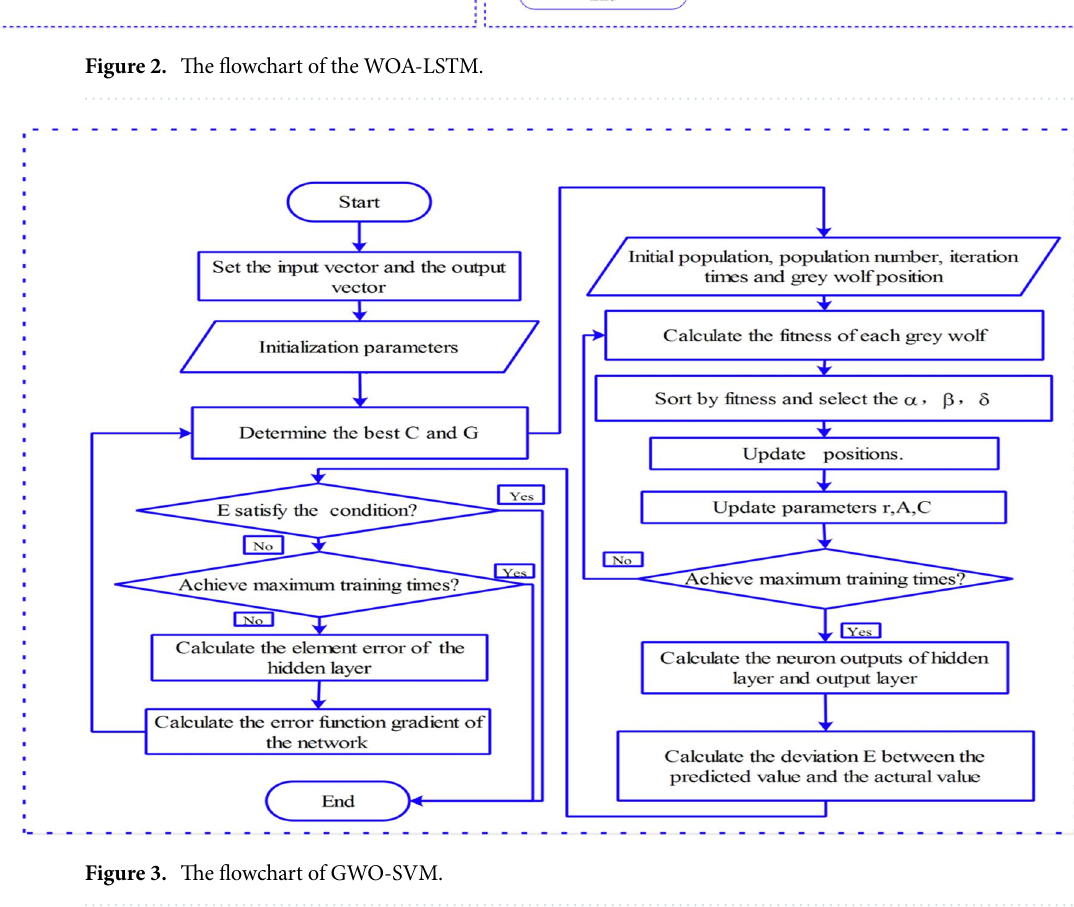
Figure 3. The flowchart of